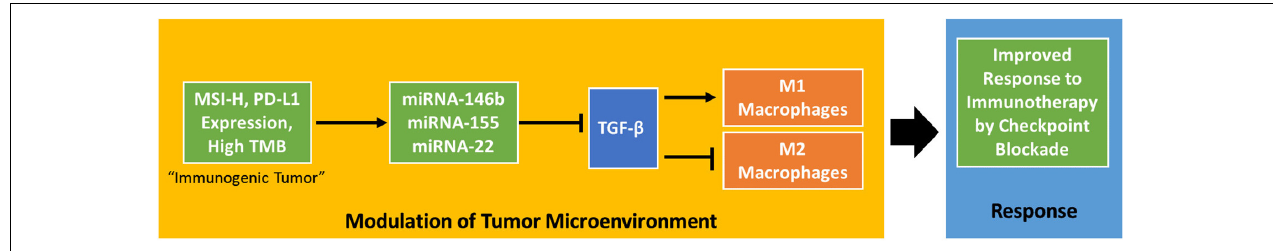
FIGURE 4 | A potential mechanism by which MSI status, PD-L1 expression, and tumor mutation burden influence the tumor microenvironment. The proposed mechanism shows that these tumor phenotypes influence the tumor microenvironment in a TGF- β -dependent way to improve response to checkpoint blockade